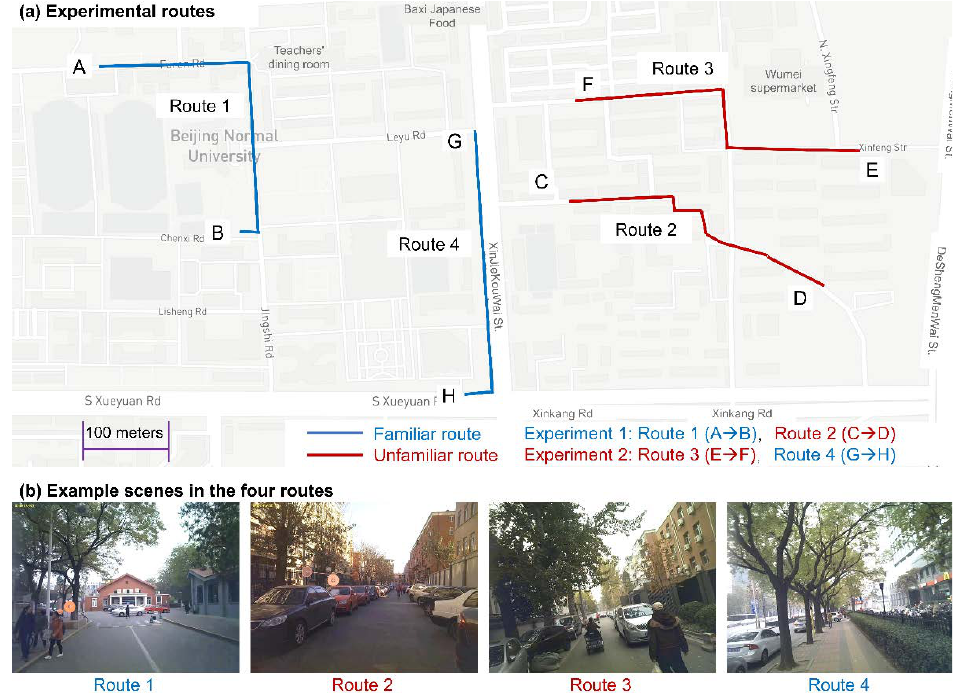
Figure 1. Experimental routes and example scenes . ( a ) Experimental routes and ( b ) example scenes of the real-world wayfinding experiments.